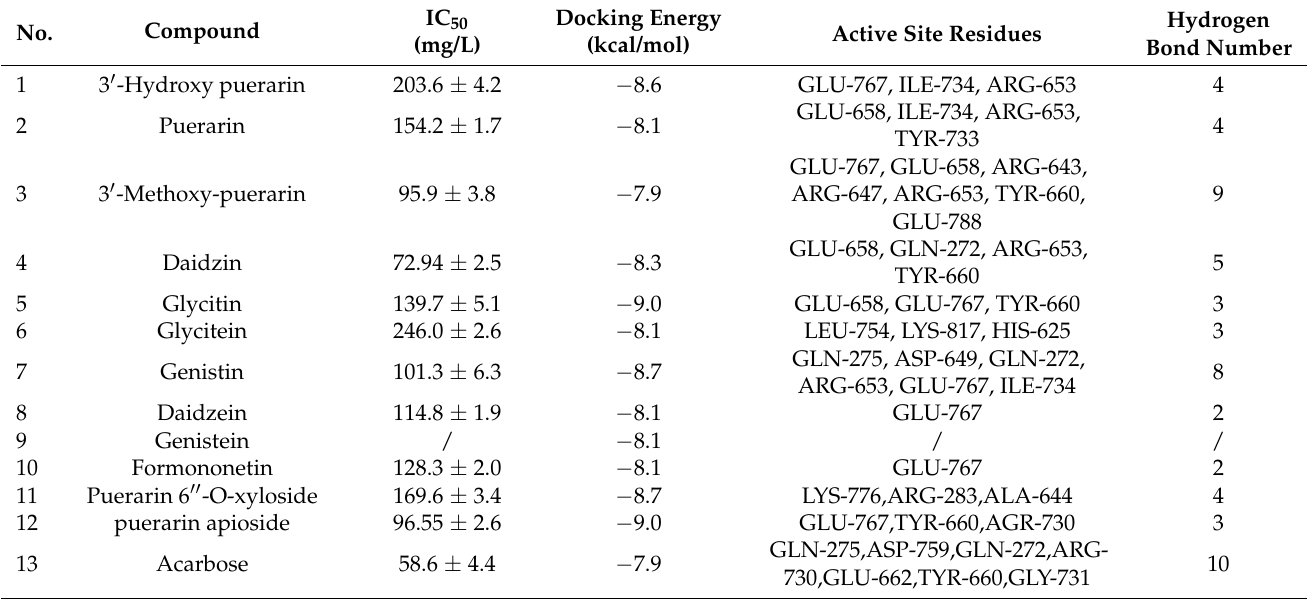
Table 5. The result of α -glucosidase inhibitory activity (IC 50 ) and molecular docking. IC